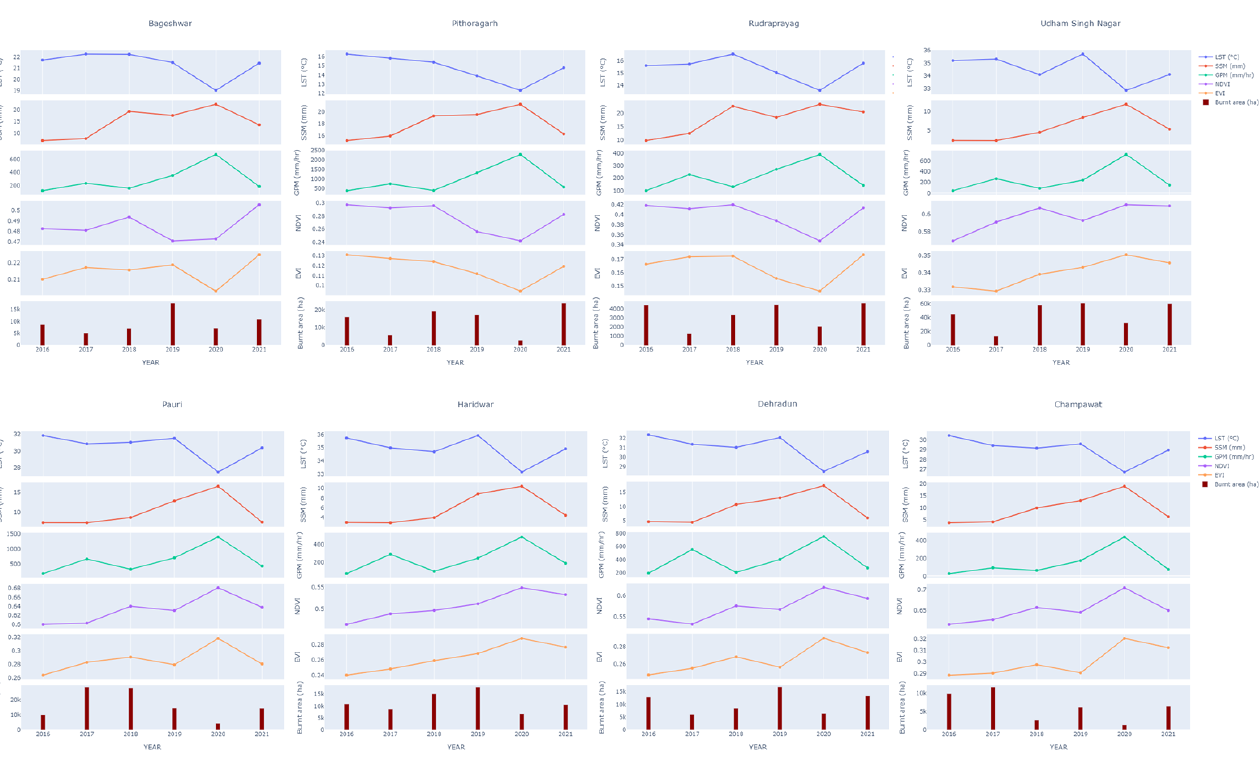
The spatio-temporal pattern of burnt area with the change in temperature, precipitation, NDVI, EVI and surface soil moisture for all the districts (except those in Figure 3) is shown in the following